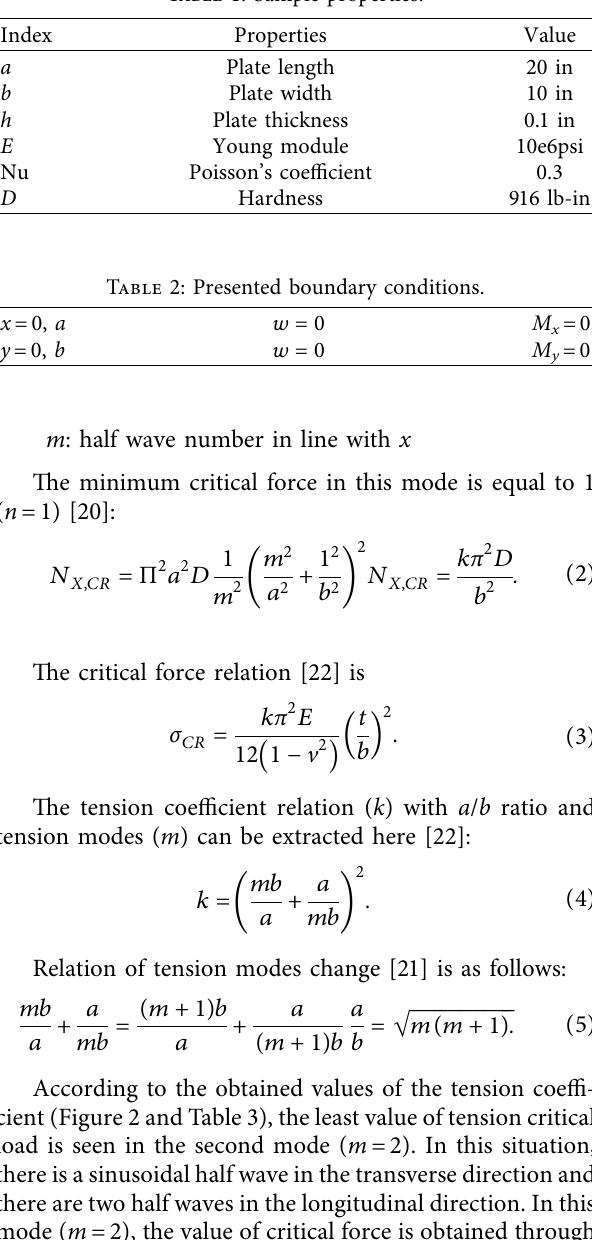
Figure 1: Flat plate under the pressure loading and included joint boundary conditions [29]. Table 1: Sample properties.